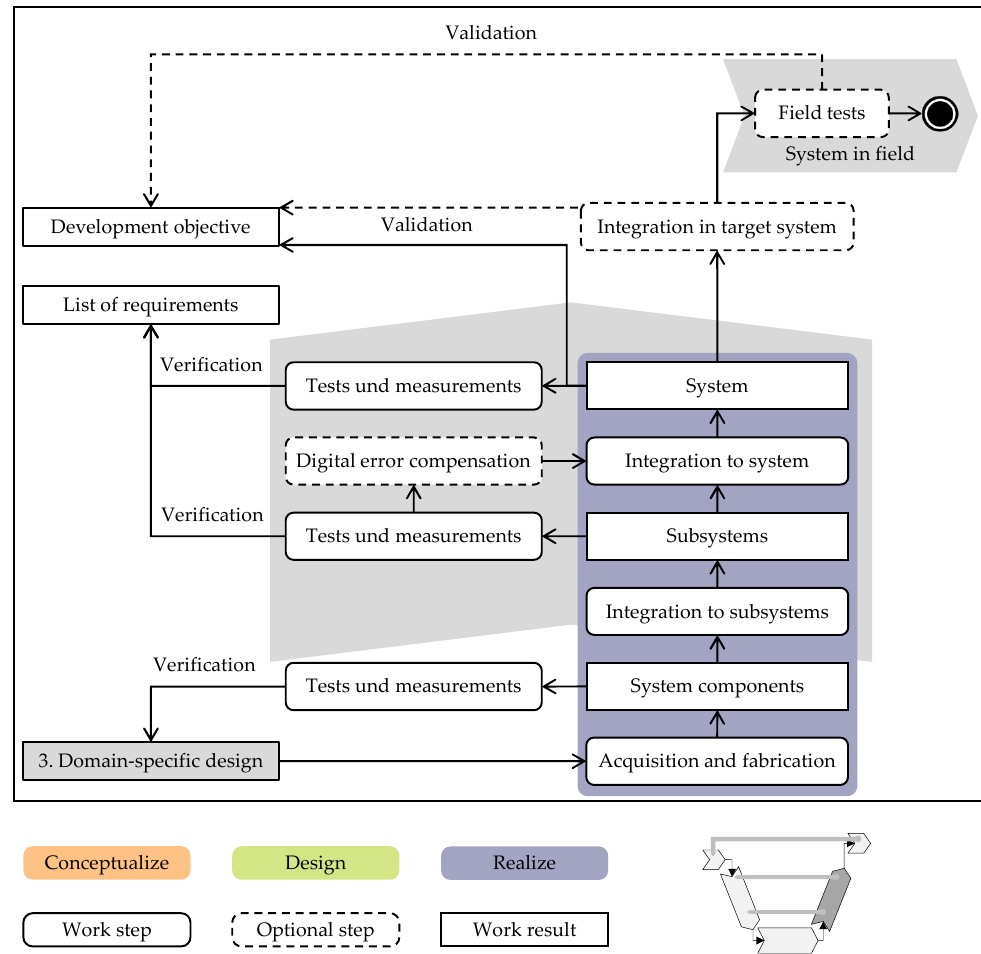
Figure 10. Process phase for system integration and assurance of properties according to